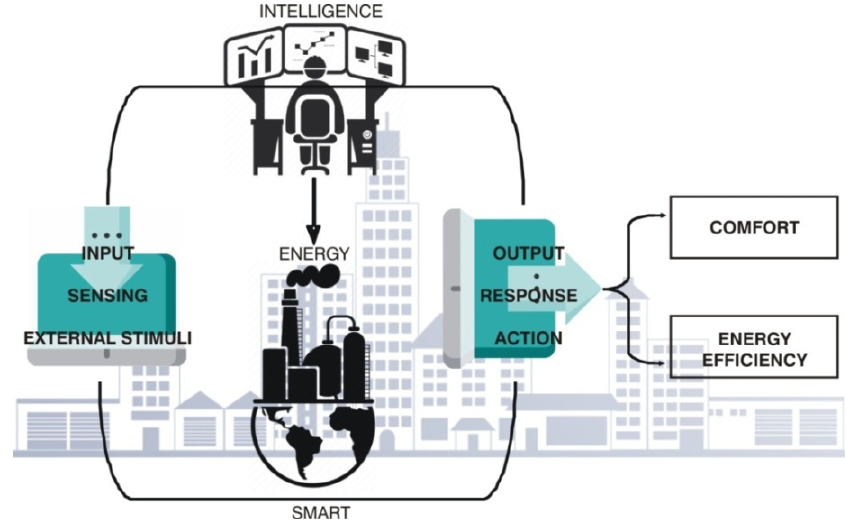
Figure 1. Conceptual framework (source: elaborated by the authors).